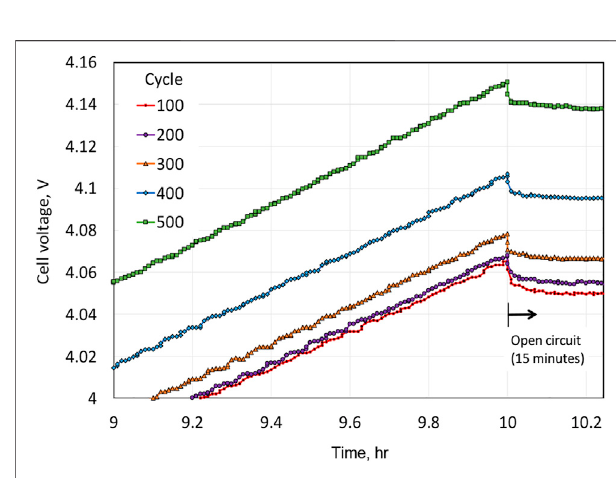
from lithiation to open